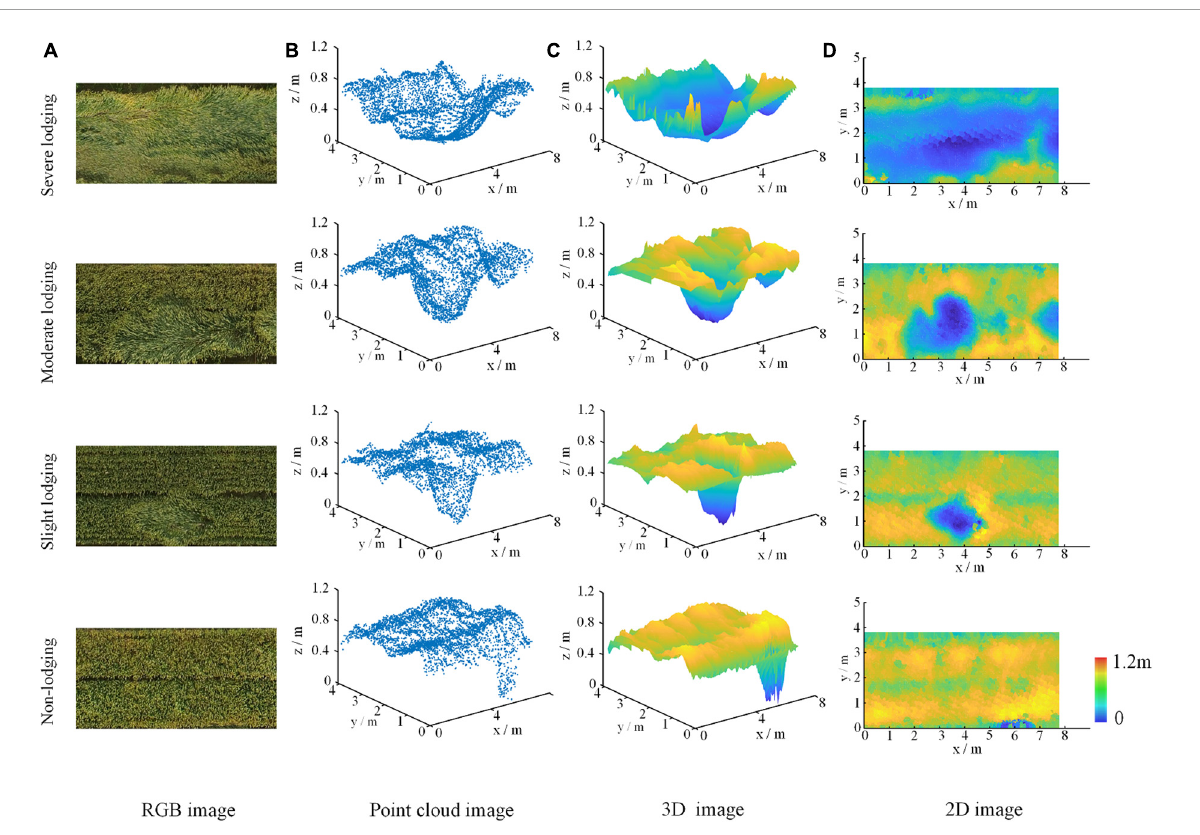
FIGURE5 The result of point cloud dimensionality reduction of wheat field at filling stage. (A) RGB image, (B) point cloud image, (C) 3D image, and (D) 2D